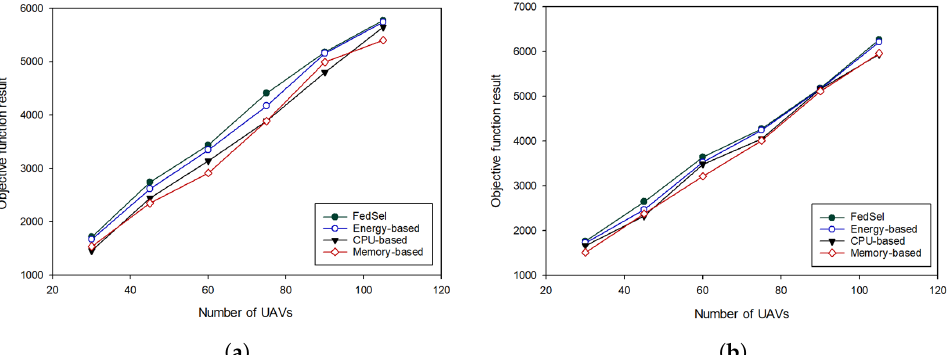
Figure 6. Performance evaluation of our UAV selection scheme in terms of objective function results while varying the number of UAVs [30, 45, 60, 75, 90, 105]. ( a ) the number of applications is 18, ( b ) the number of applications is